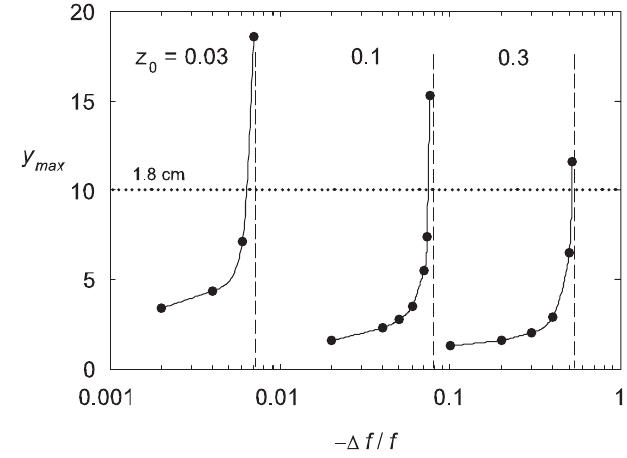
FIG. 5. Maximum beam radius y for fractional mirror shift FIG. 7. Maximum beam radius y max . As (cid:1) s change (cid:1) f=f of the right-hand mirror at several values of z (cid:1) s of the right-hand mirror at several values of z 0 diverges where the cavity becomes spherical at increases, y The minus sign in front of (cid:1) f=f indicates the focal length is max (cid:2) 4 z 2 (vertical dashed lines). The data points are taken decreasing. As the focal length decreases, y (cid:1) s max 0 the cavity becomes spherical at (cid:1) f=f (cid:2) (cid:4) 8 z 2 from ray and beam simulations; the solid lines are guides to the (cid:2) 10 tical dashed lines). The points are taken from ray simulations and eye. For an FEL with S (cid:2) 10 m and (cid:1) (cid:2) 1 (cid:4) m , y max beam calculations; the solid lines are guides to the corresponds to 1.8 cm.